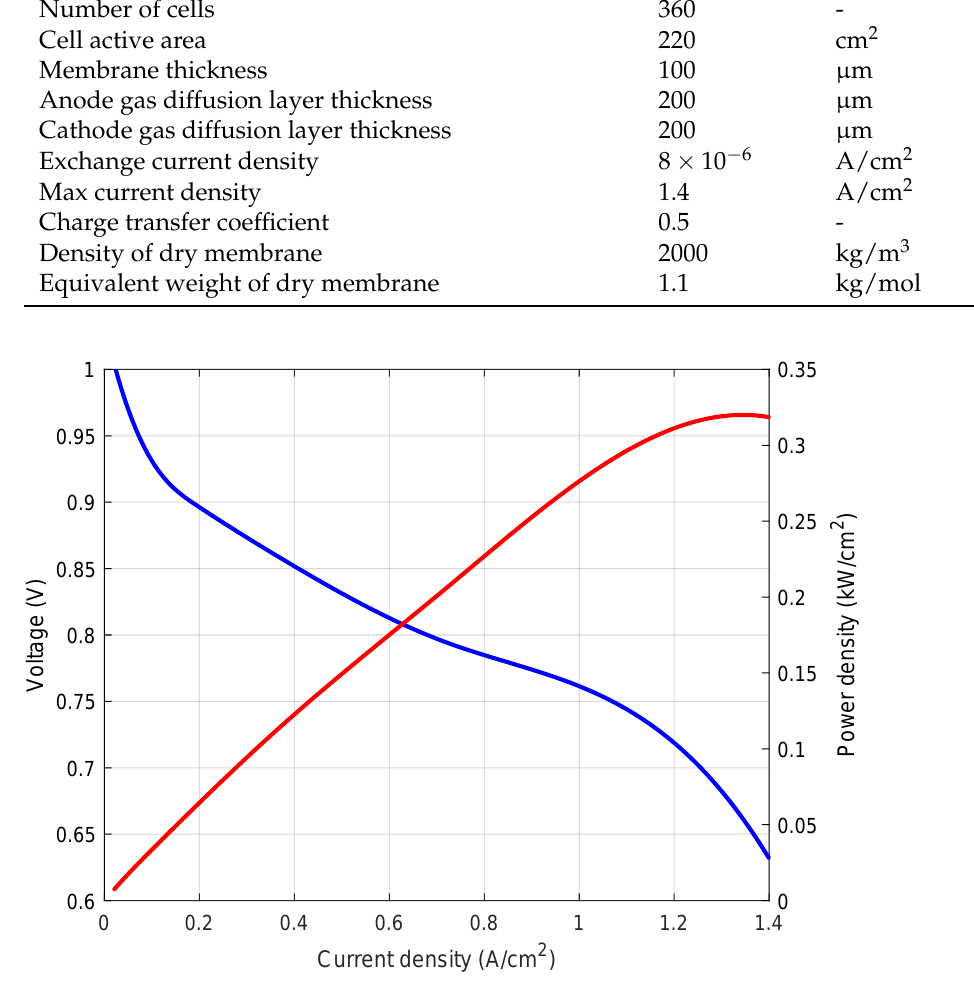
Figure 8. Cell voltage and power density curves as functions of current density.